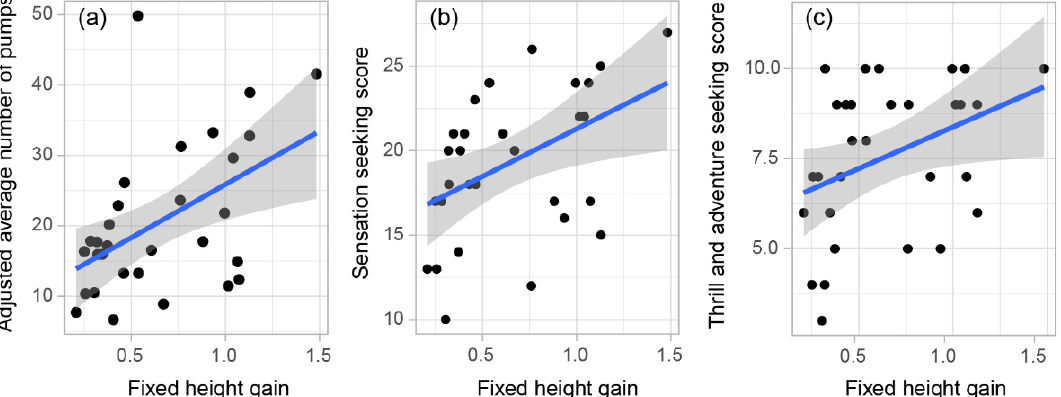
Figure 3. Scatter plots for the Single Collapse condition of the TBT in relation to ( a ) the BART, ( b ) the SSS, and ( c ) the Thrill and Adventure Seeking subscale of the SSS. Filled circles show participants’ fixed height gain on the x -axis, and on the y -axis ( a ) the adjusted average number of pumps, ( b ) the overall SSS, and ( c ) the SSS subscale Thrill and Adventure Seeking score. Blue lines show the linear association between the two variables of each plot and the gray areas indicate the confidence intervals.